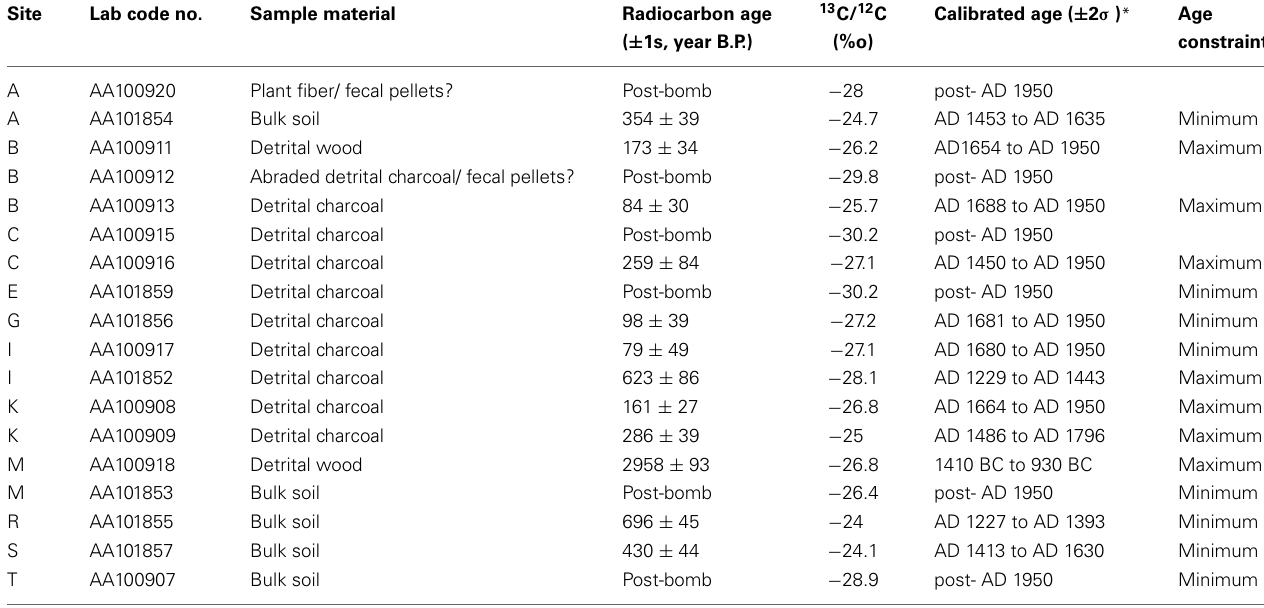
Table 2 | AMS (accelerator mass spectrometry) radiocarbon age analyses results. Site